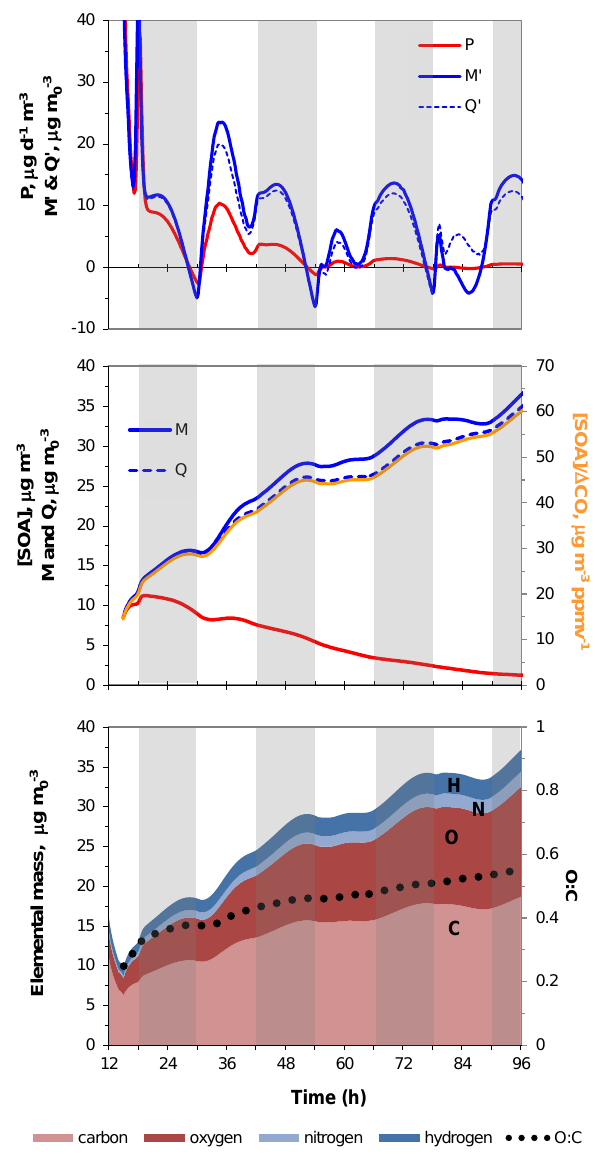
Fig. 11. Aerosol production during the Lagrangian run. (a) SOA production rates. (b) SOA concentration and mass in the dispersing air parcel. (c) Elemental composition of dispersing aerosol mass M . Grey shaded regions indicate approximate hours of